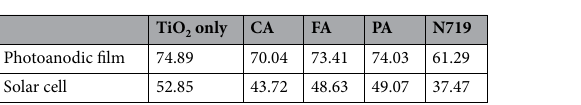
Figure 5. Photographs and transmittance spectra of ( a ) dye-grafted films and ( b ) DSSCs.